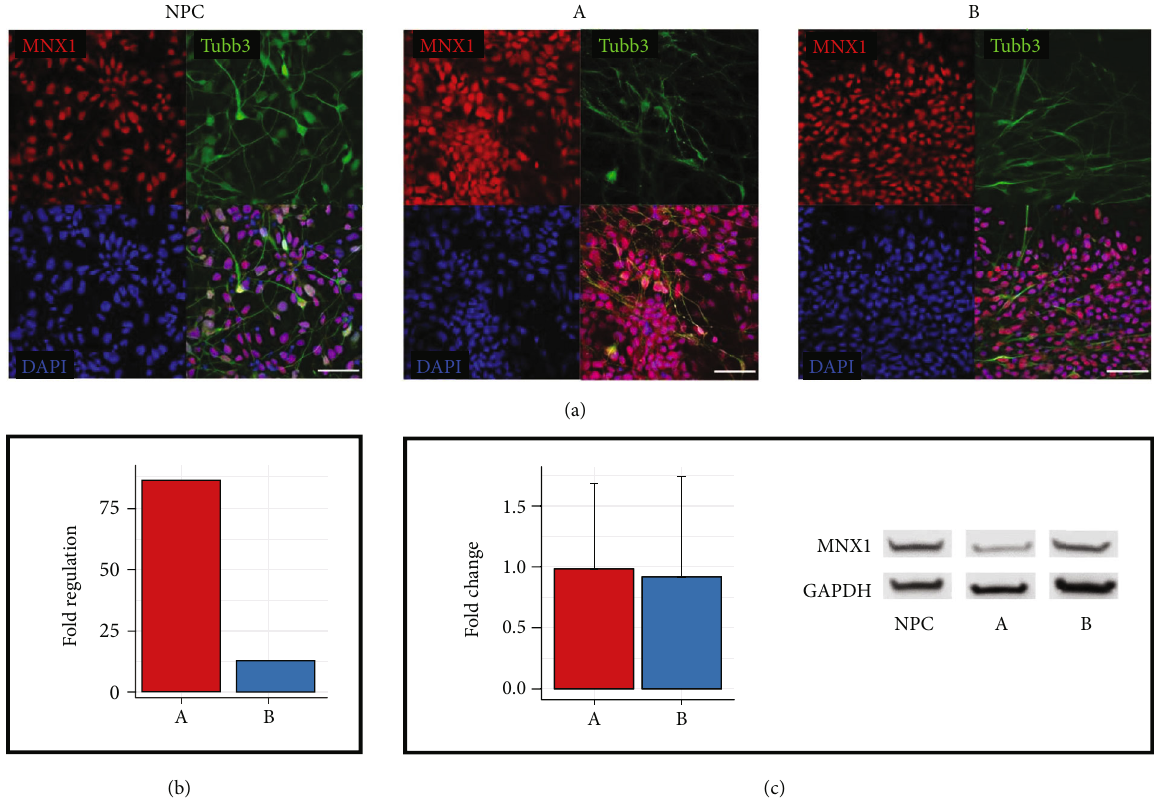
Figure 5: Motoneuronal di ff erentiation marker MNX1. (a) Representative immuno fl uorescent images of MNX1 (red) staining show nuclear expression in NPC and neurons of approach A and B. Cell nuclei were counterstained with DAPI (blue). Scale bars, 50 μ m. (b) Detected via qRT-PCR, MNX1 was upregulated in both approaches in comparison to NPC ( n = three independent experiments). See Figure 3 for all results. (c) Indi ff erent MNX1 protein expression was detected using Western Blot. Representative bands are shown from three independent experiments. Each bar represents the fold change mean ± SD